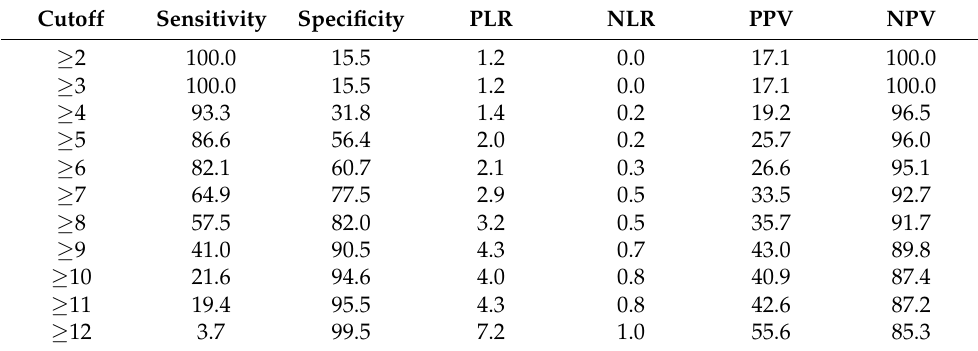
model. Based on these, we developed the new prognostic model for predicting significant stenosis on CCTA, and the Hosmer-Lemeshow test showed that the model fitted the data Figure 2 shoed observed occurrence of significant stenosis according to the new score. well ( p = 0.848). Higher score tent to had higher proportion of the severe narrowing on coronary arteries. Figure 3 were ROC curve of the new model, and AUC was 0.782 (95% CI 0.742–0.822), Table 2. Multivariate analysis and new prognostic model for predicting significant stenosis. p < 0.001. Cut-off value of 5 point which was calculated by using the Youden index showed 86.6% of sensitivity and 56.4% of specificity (Table 3). Table 3. Diagnostic performance in predicting the significant stenosis in the validation set.